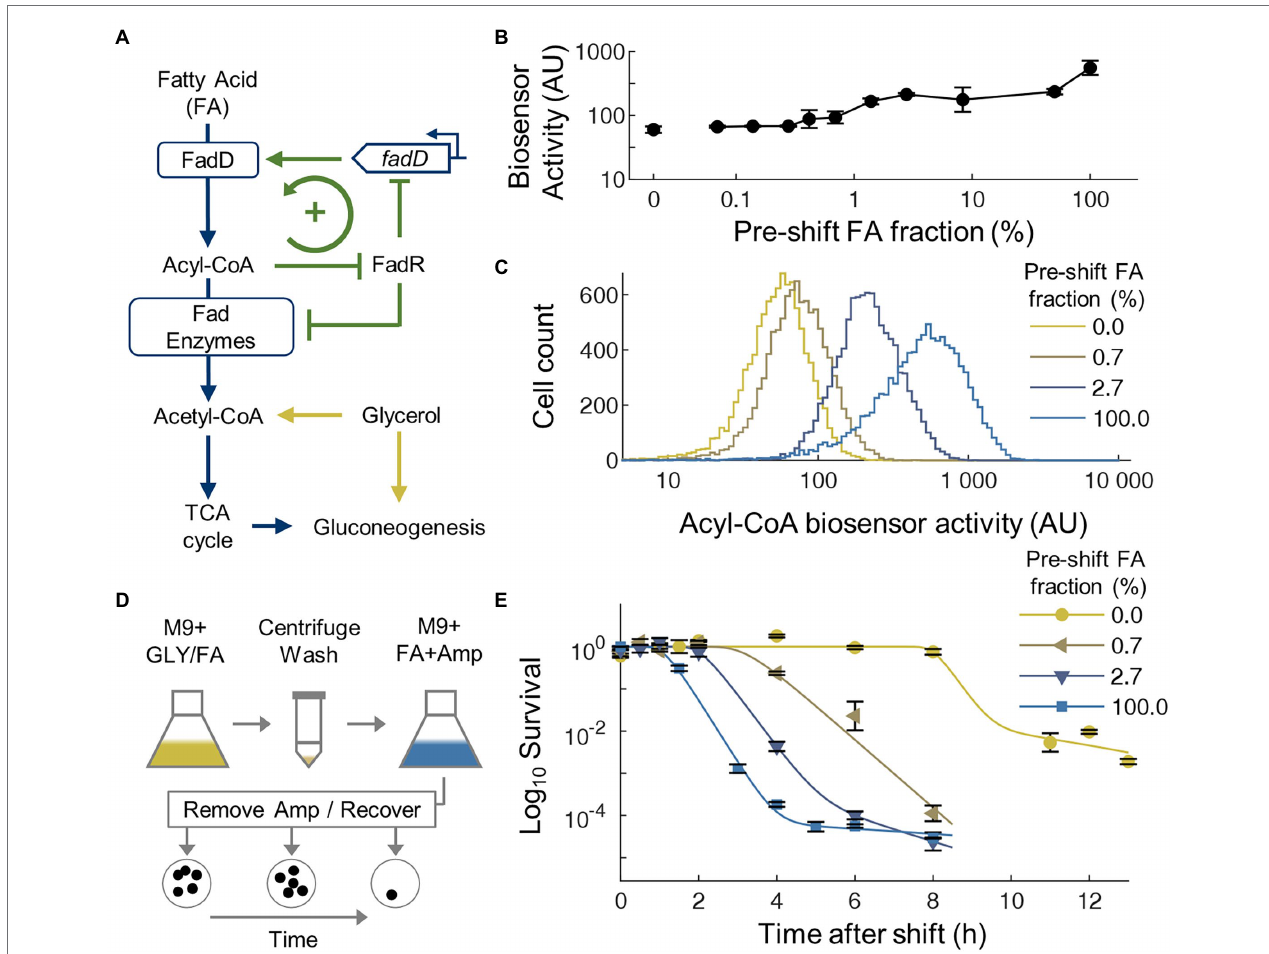
FIGURE 1 | Transitions from glycerol to fatty acid (FA) generate transient ampicillin tolerance. (A) Simplified metabolic and regulatory network for FA and glycerol utilization. (B) Average acyl-CoA biosensor activity during co-utilization of FA and glycerol at different ratios. Across all conditions, the total concentration of carbon is constant at 72 mM. (C) Single-cell distribution of acyl-CoA biosensor activity during co-utilization of FA and glycerol at different ratios. A single representative distribution is shown per condition, n = 10,000 per distribution. All distributions are unimodal, with the mean shifting higher for higher fractions of FA. (D) Illustration of media switching and antibiotic killing experimental protocol. GLY, glycerol; Amp, ampicillin; and FA, fatty acid. (E) Time course survival curves of cells after nutrient shifts from mixtures of glycerol and FA to 100% FA with 100 μ g/ml ampicillin. The glycerol/FA fraction in the pre-switch correspond with the conditions displayed for the distributions in C . Average of biological replicates, n = 3, error bars represent SEM. Curves are fitting of the Gompertz model to experimental